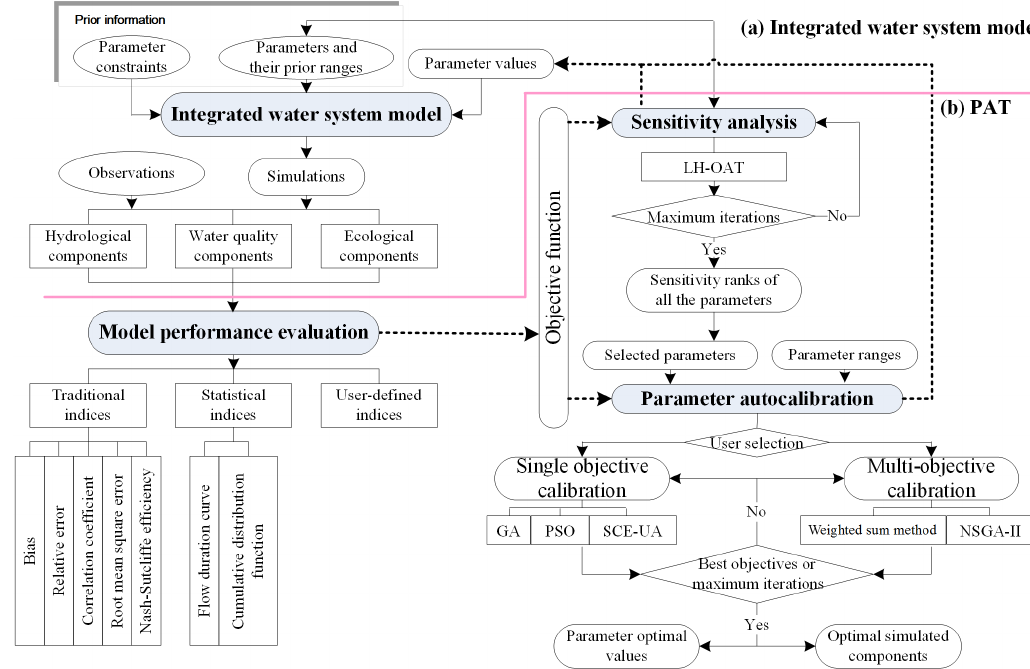
Figure 5. The flowchart of PAT and its interactions with other